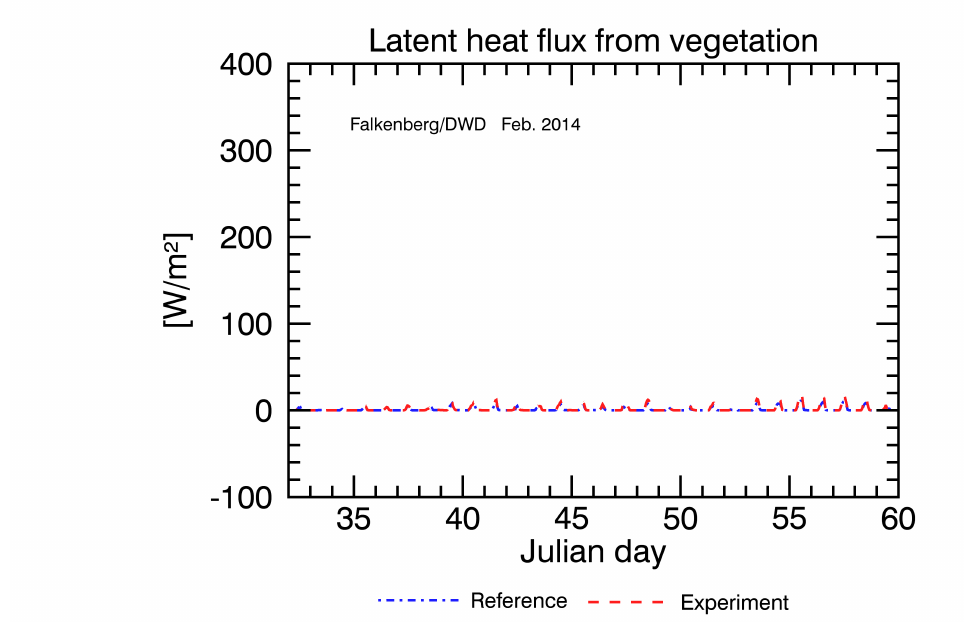
Figure 2. Same as Figure 1 but for the latent heat flux from